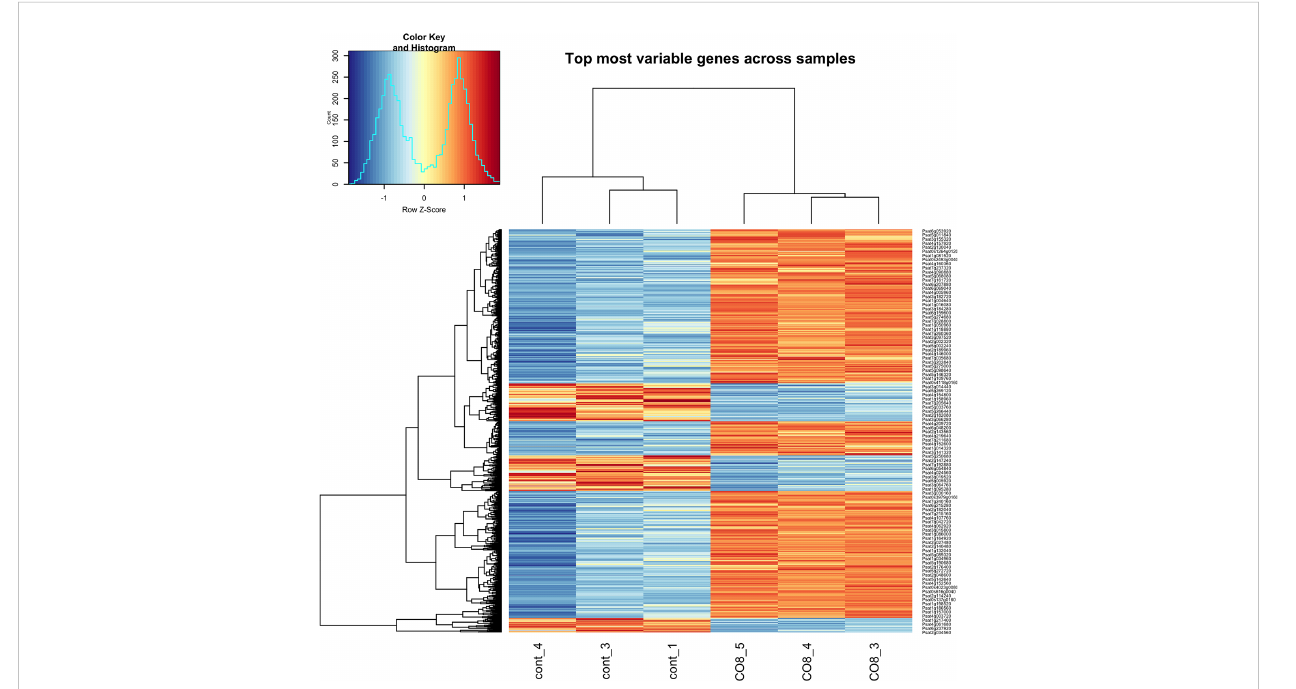
FIGURE 1 Differentially expressed genes (DEGs) in a cluster-wise heatmap of 6 biological replicas 24 h after CO8-DA treatment (Log2 fold change ≥ 1, p-value <